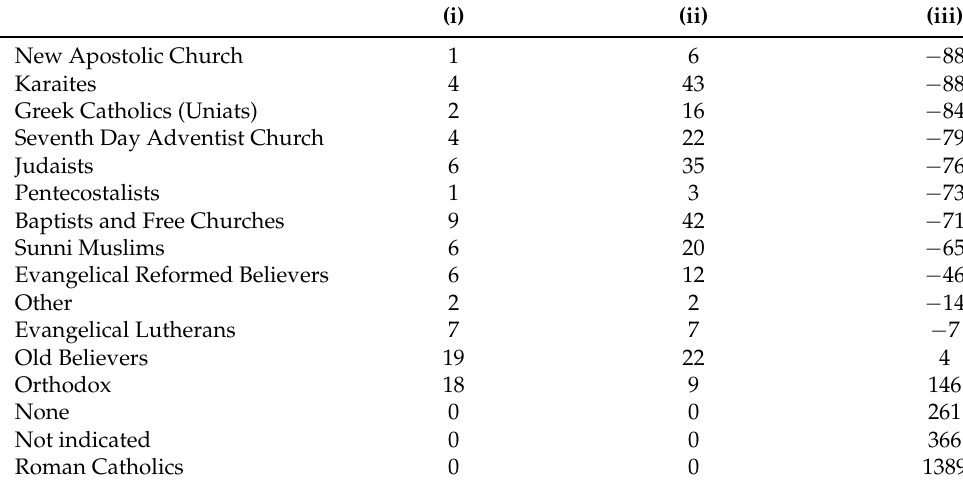
Table 5. Comparison of the relative difference (in %): (i) ( ˆ ψ GRs − (cid:98) V C1 ) / (cid:98) V C1 , (ii) ( ˆ ψ GDs − (cid:98) V C2 ) / (cid:98) V C2